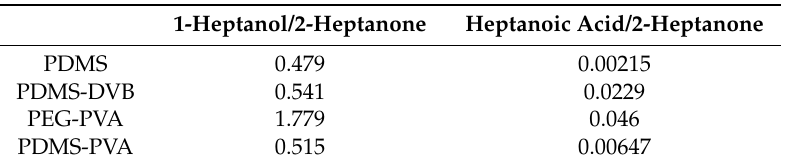
Table 2. Adsorption specificity of composite adsorbents. Adsorption amounts determined from the total ion current (TIC values) were normalized to the TIC values for adsorbed 2-heptanone on each adsorbent.